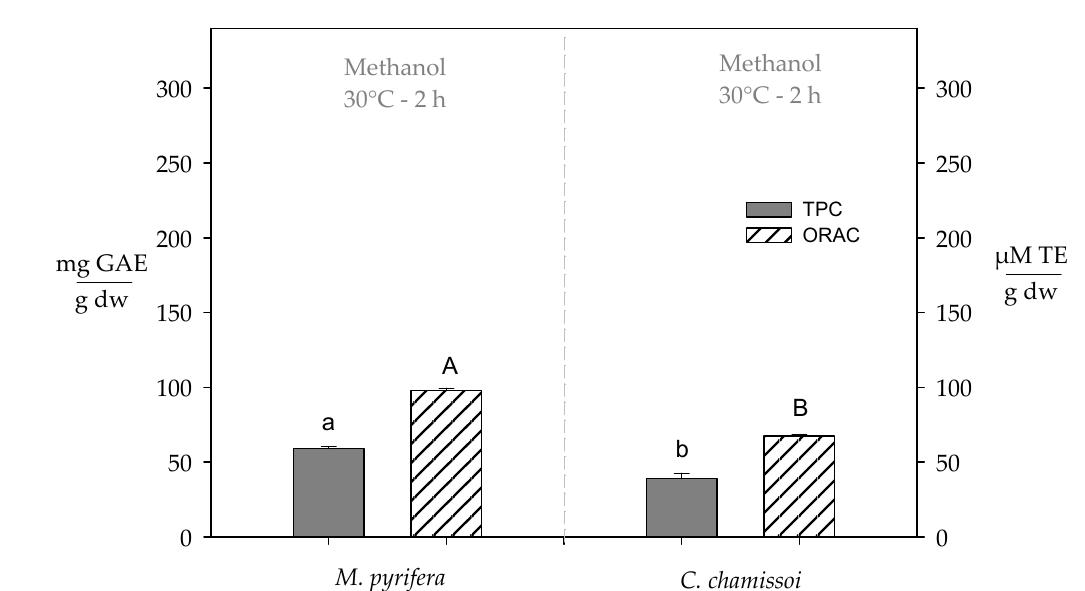
Figure 1. Total content of polyphenols and antioxidant capacity of methanolic extracts obtained from Peruvian brown and red seaweed. The significant differences ( p < 0.05) between M. pyrifera and C. chamissoi were established with different lower-case letters and capital letters for TPC and ORAC, respectively.